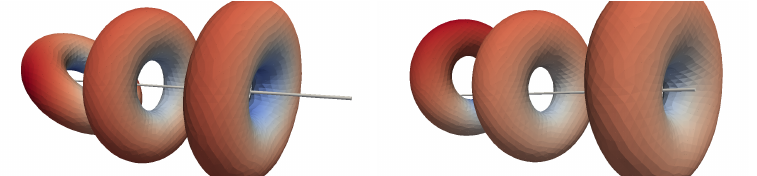
= 16.5 showing “correction” 0